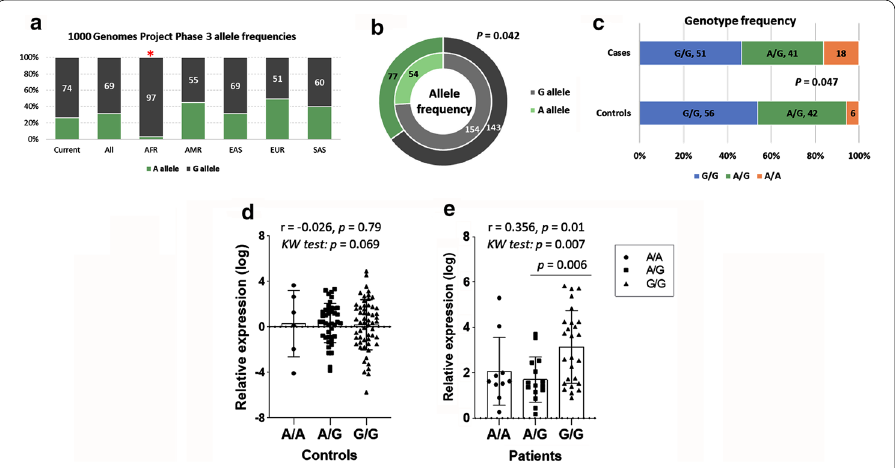
Fig. 2 Genotype and allele frequencies of CDKN2B-AS1 (rs2383207) variant and association with gene expression. a – c A two-sided Chi-square test was used. d , e Spearman’s correlation analysis was done, revealing the coefficient correlation value (r) and its P -value. Kruskal–Wallis (KW) test was applied to test for significant difference between cohorts with genotypes. Multiple comparison test was applied for pairwise comparison. Statistical significance was set at P -value <